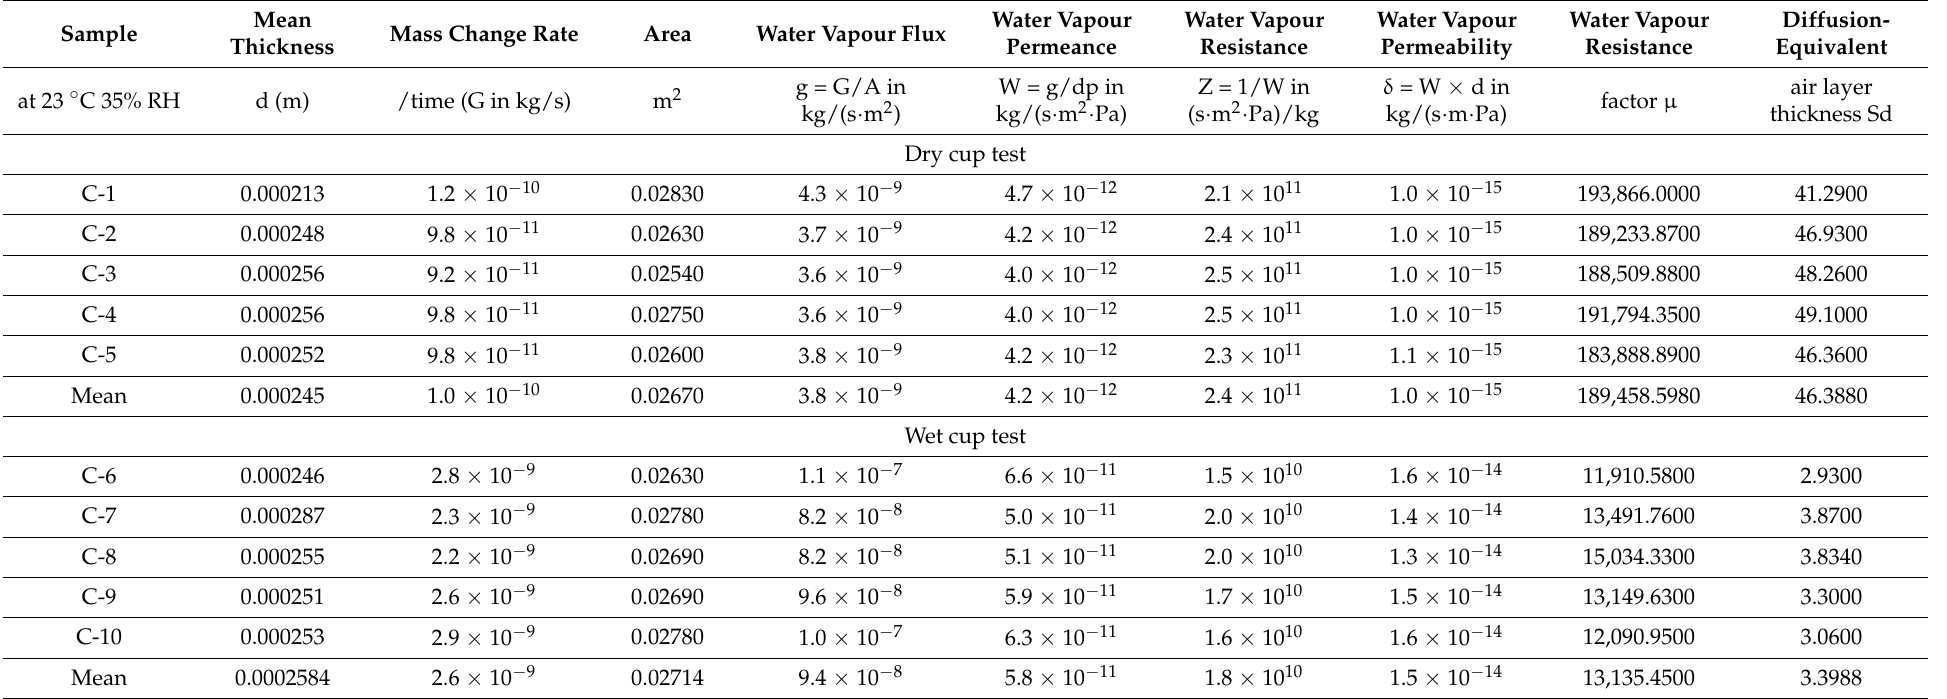
Table A2. Water vapour resistivity properties for sample C at 35% RH 23 ◦